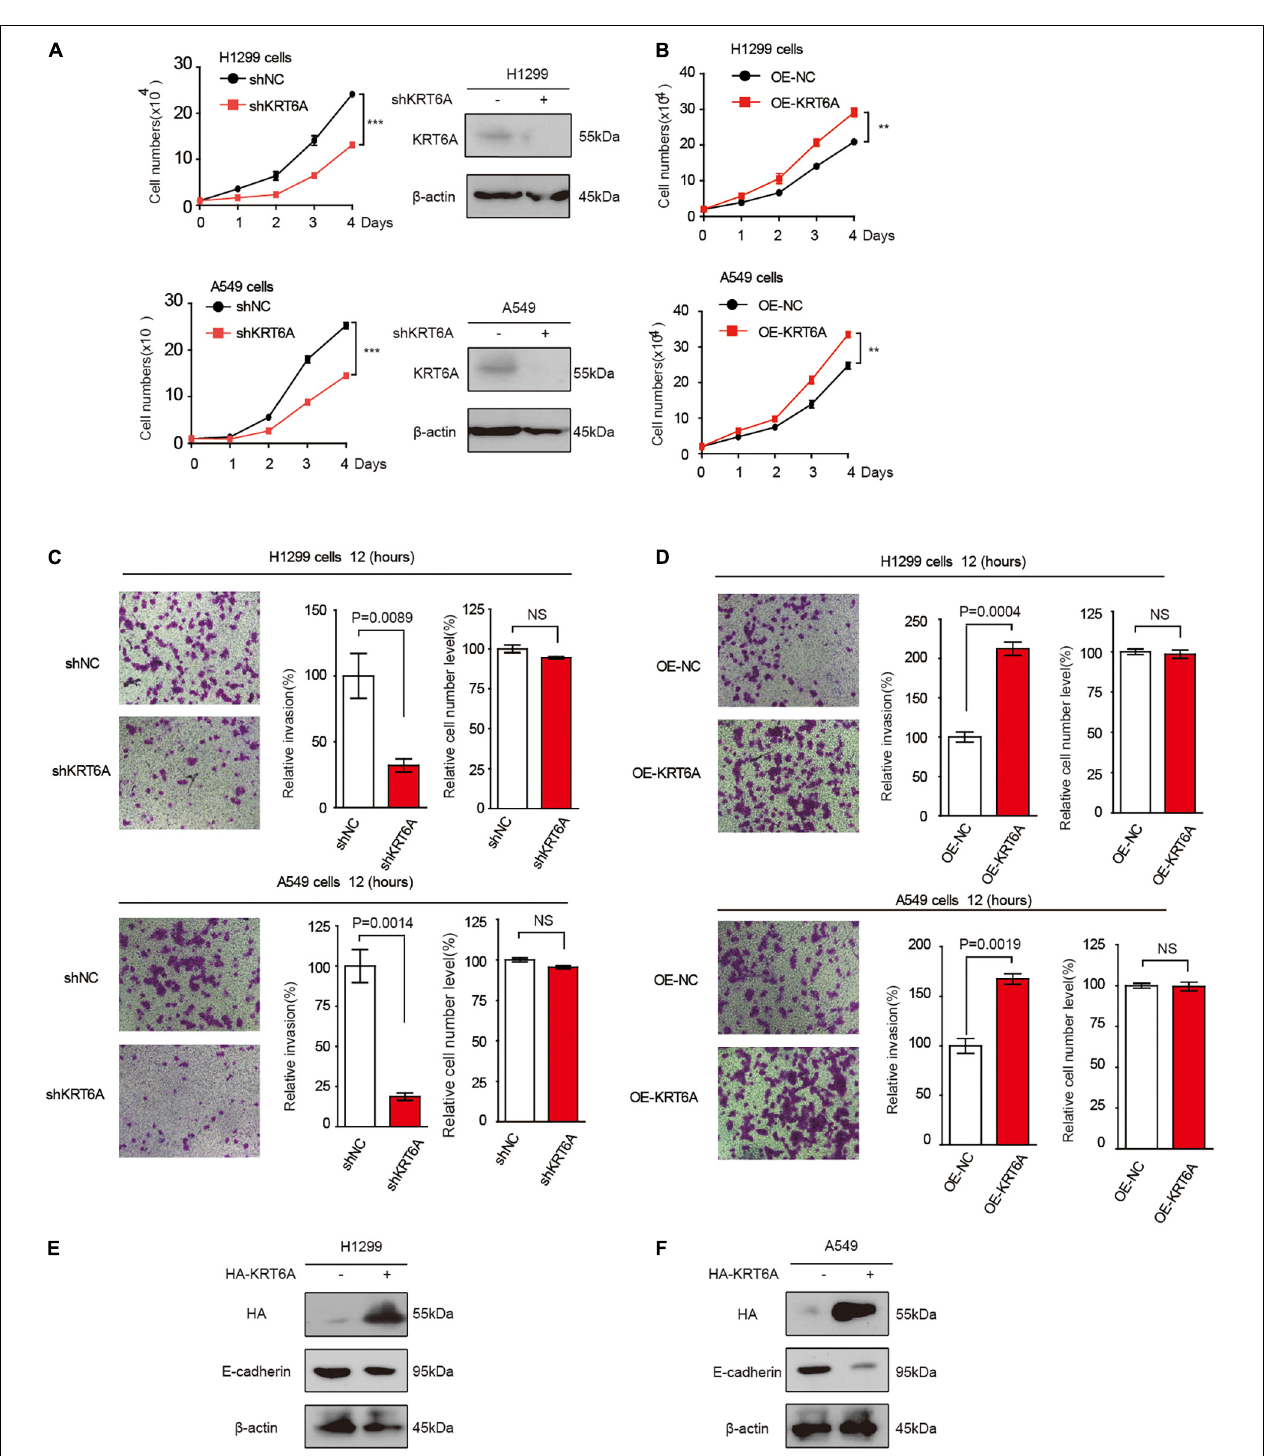
FIGURE 2 | KRT6A promotes lung cancer cell proliferation and invasion. (A) Cell proliferation rates of human lung cancer H1299 and A549 cells with stable knockdown of KRT6A. (B) Cell proliferation rates of human lung cancer H1299 and A549 cells with stable expression of KRT6A. (C) Transwell assay of cell invasion was performed in human lung cancer H1299 and A549 cells with stable knockdown of KRT6A. (D) Transwell assay of cell invasion was performed in human lung cancer H1299 and A549 cells with stable expression of KRT6A. (E,F) Overexpression of KRT6A significantly decreases E-cadherin levels in H1299 and A549 cells (**0.001 < p < 0.01; *** p <